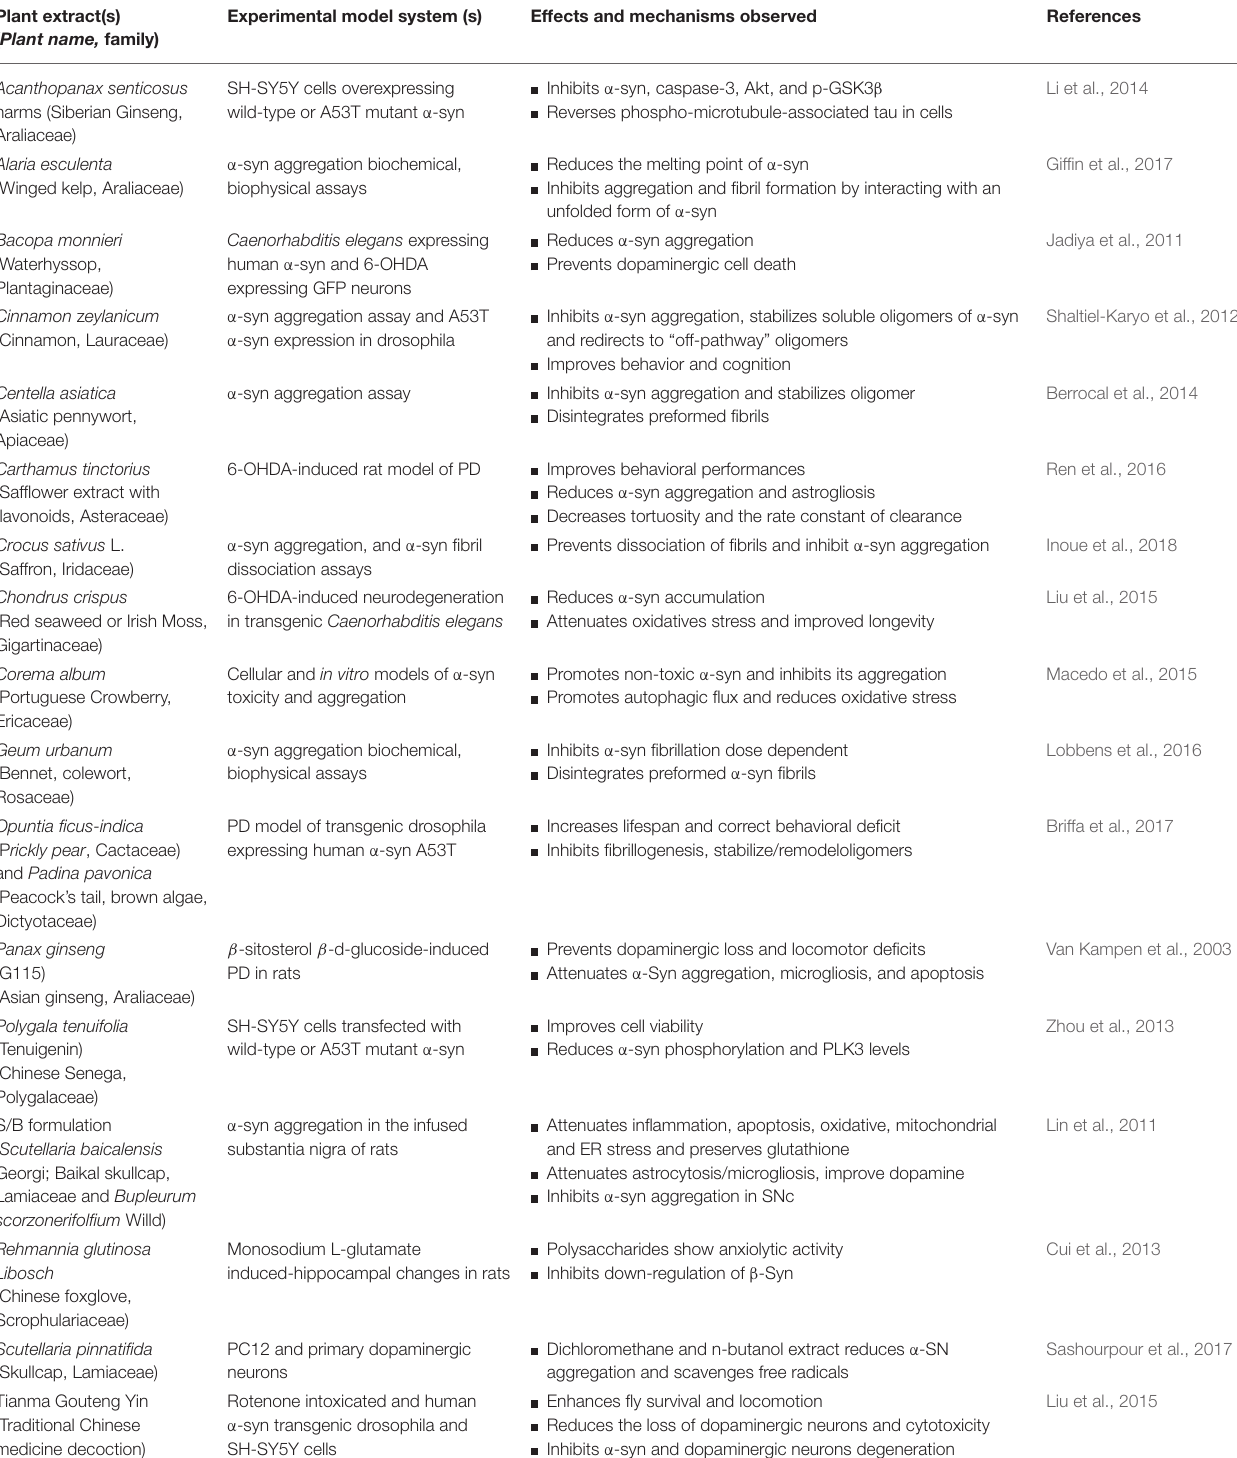
TABLE 1 | The plant extracts and formulations providing neuroprotection in Parkinson’s disease models by targeting α -synuclein. Plant extract(s) ( Plant name,